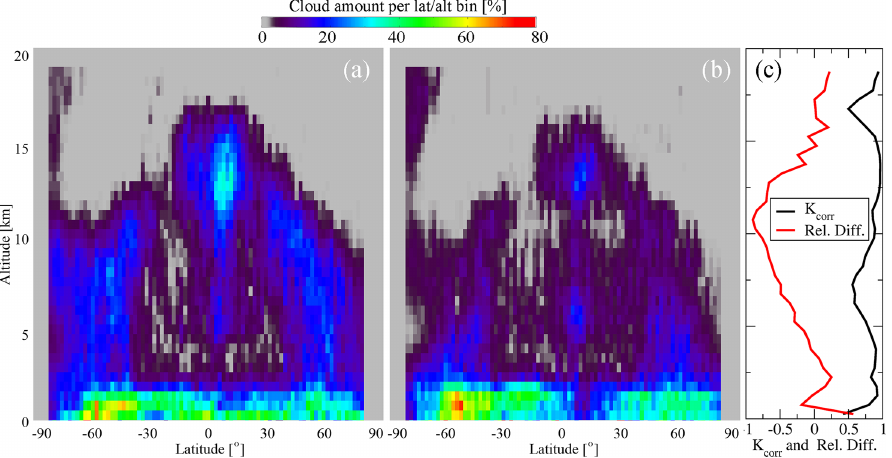
Figure 8. Latitudinal–altitudinal distributions of cloud amount defined from (a) CALIOP and (b) ALADIN and altitudinal profiles of Pear- son’s correlation coefficient and relative difference between ALADIN and CALIOP (c)